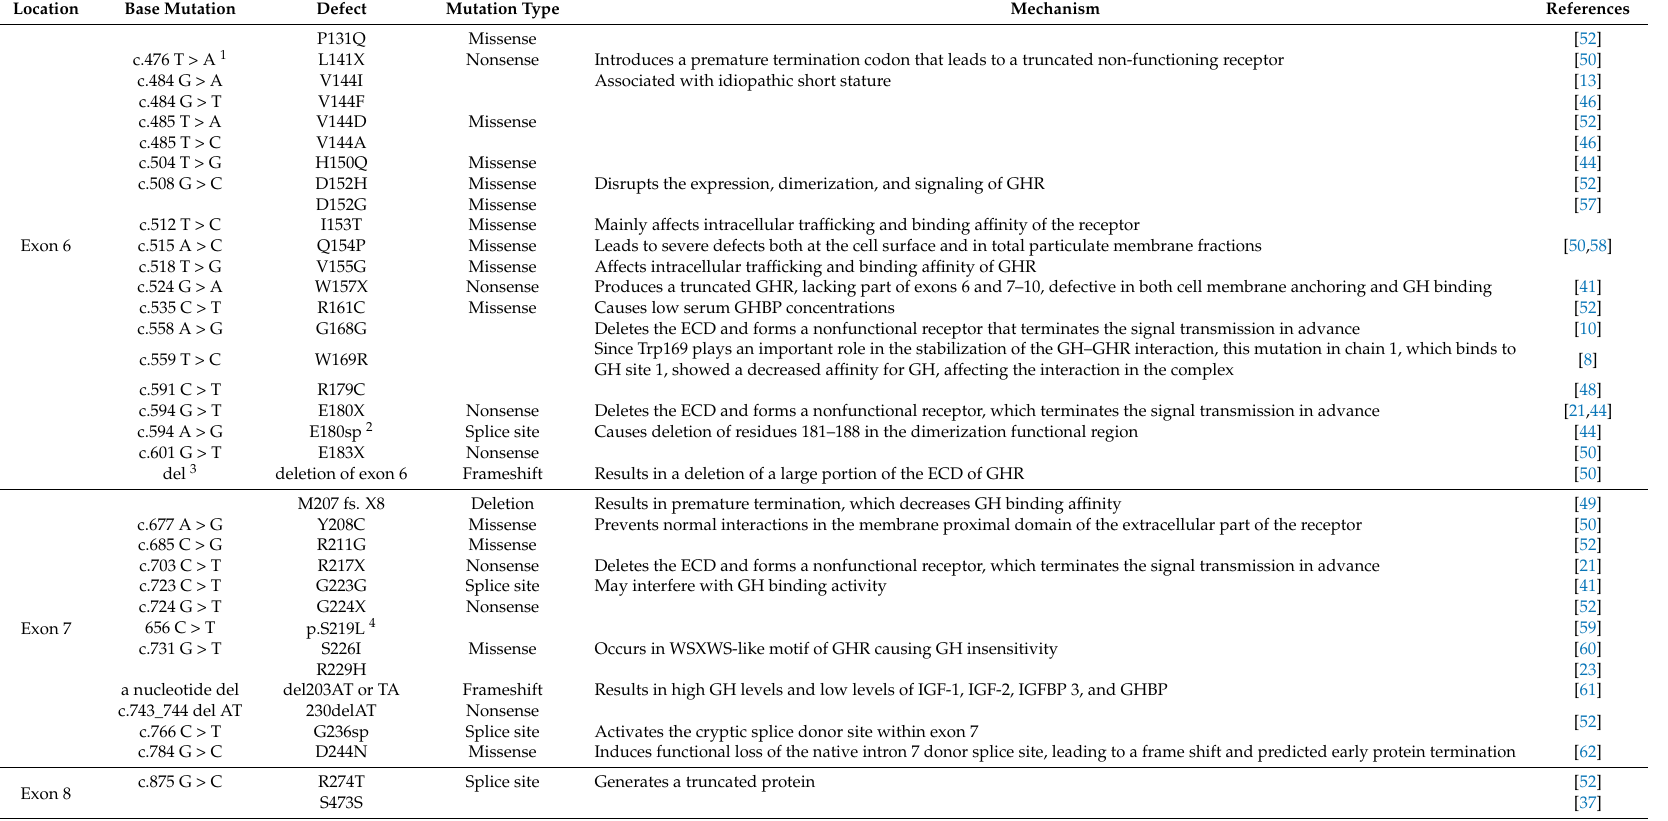
Table 2. Mutations in the GHR dimerization domain relevant to human